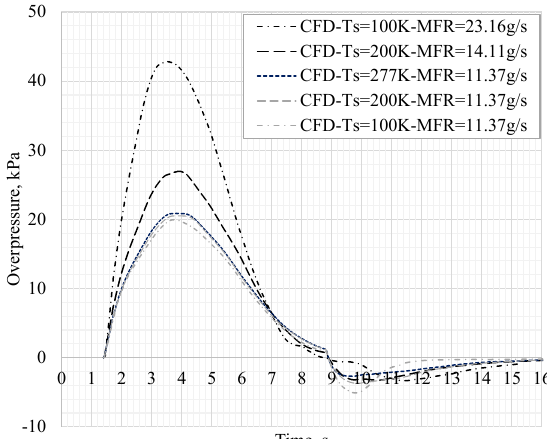
Figure 9. Effect of hydrogen storage temperature on the PPP dynamics in the enclosure with volume of 15 m 3 and three vents with dimensions 7 × 7 cm. sEq.(1)-Vc,in-Ts=277K-MFR=11.37g/s CFD-Vv,out-Ts=277K-MFR=11.37g/s Eq.(1)-Vc,in-Ts=100K-MFR=23.16g/s CFD-Vv,out-Ts=100K-MFR=23.16g/s